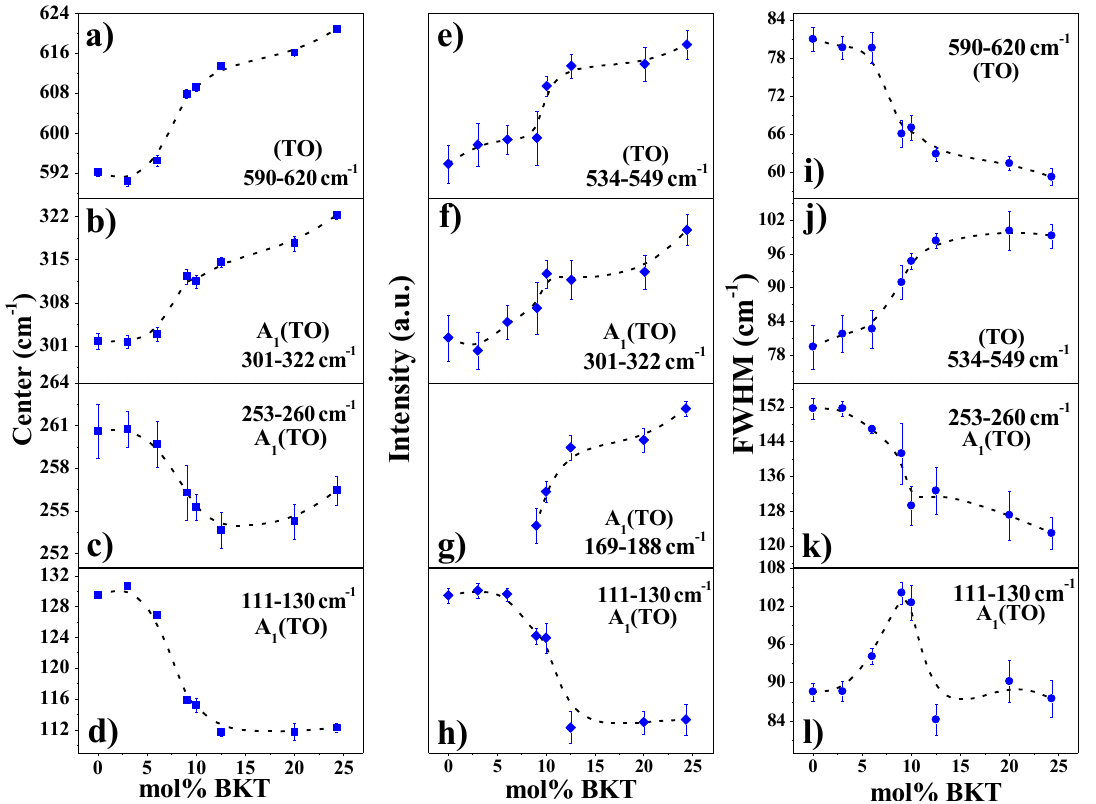
Figure 4. Variations in ( a – d ) center, ( e – h ) intensity, and ( i – l ) FWHM of the Raman spectra deconvoluted peaks from studied compositions as a function of mol % BKT content.